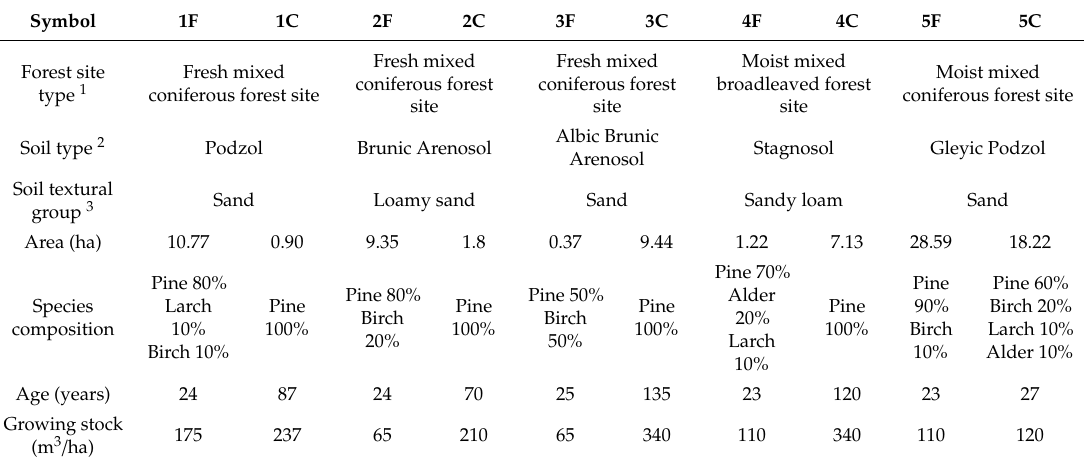
Table 1. Characteristics of forest compartments where the research was located.